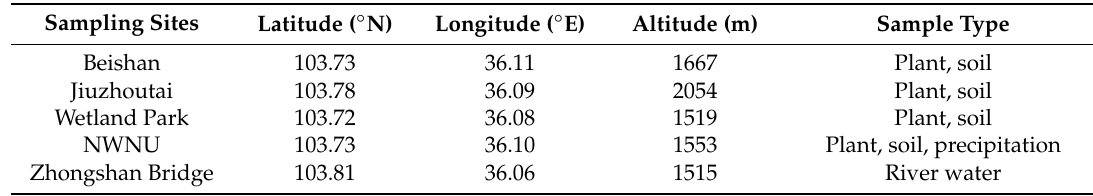
Table 1. Details of sampling sites in Lanzhou